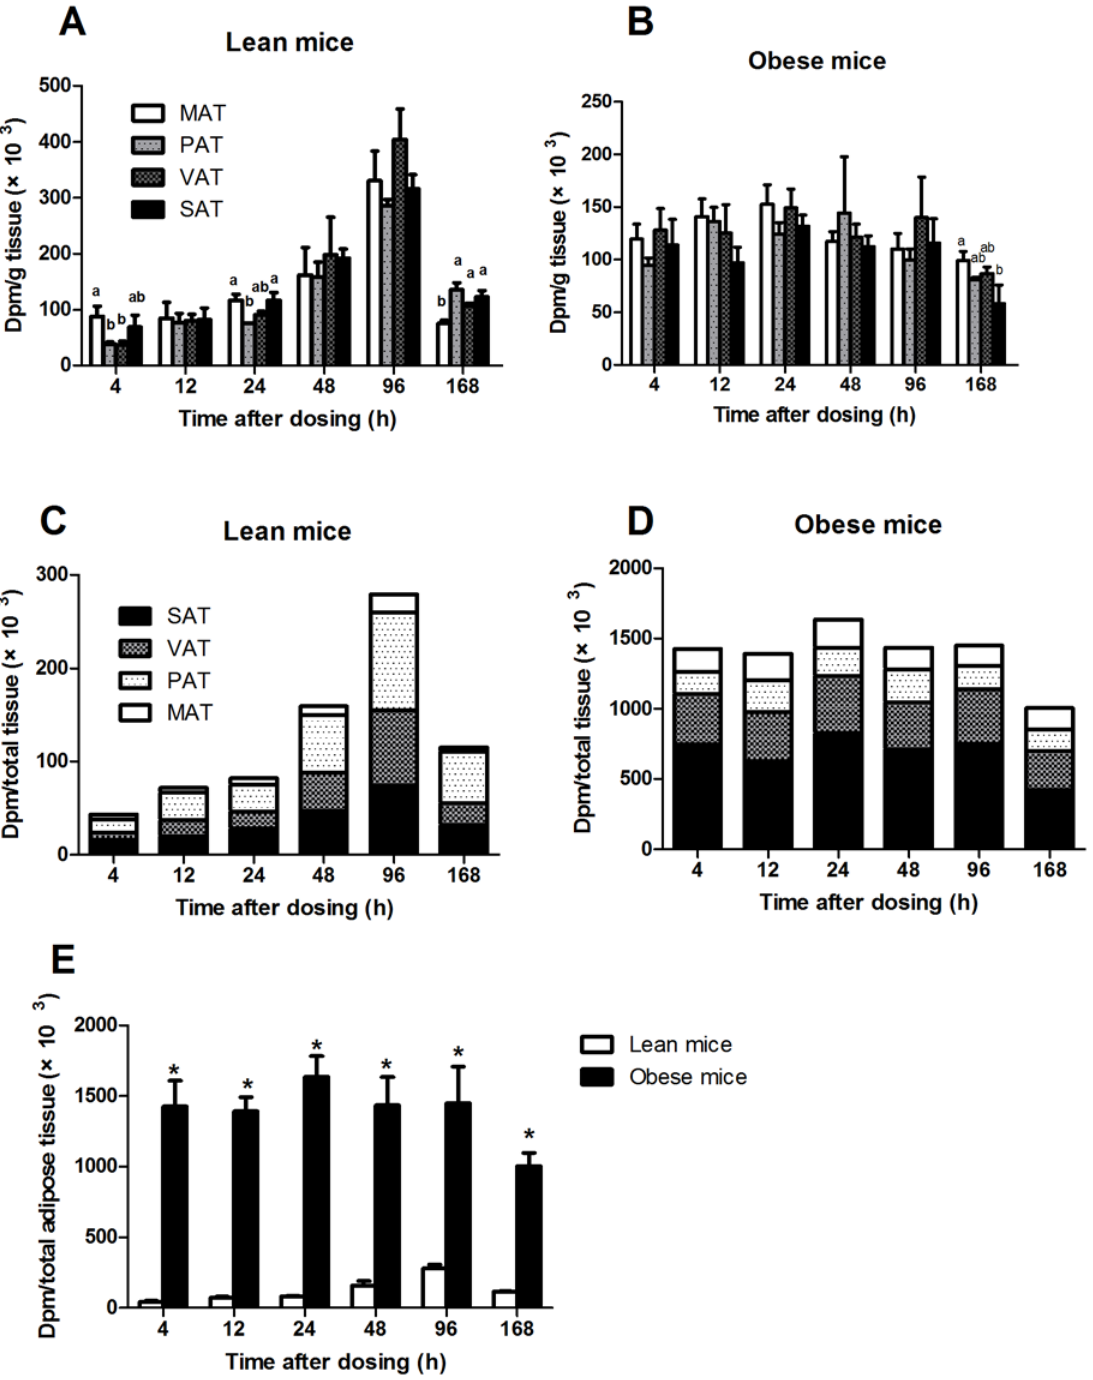
Fig 5. The concentration of 14 C-label (dpm/g tissue) in various fat depots (MAT, PAT, VAT and SAT) from lean mice (A) and obese mice (B). The total 14 C-label content (dpm/total tissue) in various fat depots (MAT, PAT, VAT and SAT) from lean mice (C) and obese mice (D). Comparison of the total 14 C-label content in adipose tissue (MAT+PAT+VAT+SAT) between lean and obese mice (E). The data are presented as the mean ± SEM (n = 3). Different letters indicate significant differences between different adipose depots at a particular time point ( P < 0.05). Asterisks ( * ) indicate significant differences between lean and obese mice at a particular time point ( P < 0.05). MAT, mesenteric adipose tissue, PAT, perirenal adipose tissue, VAT, visceral adipose tissue, SAT, subcutaneous adipose tissue.